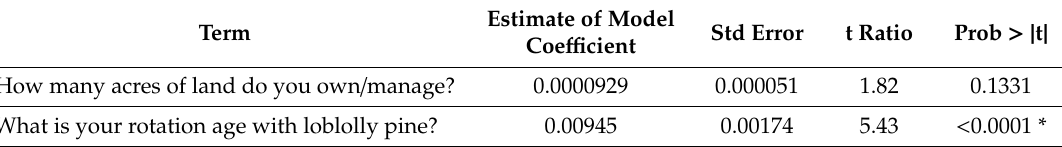
Table 3. Parameter estimates—distance to a mill.